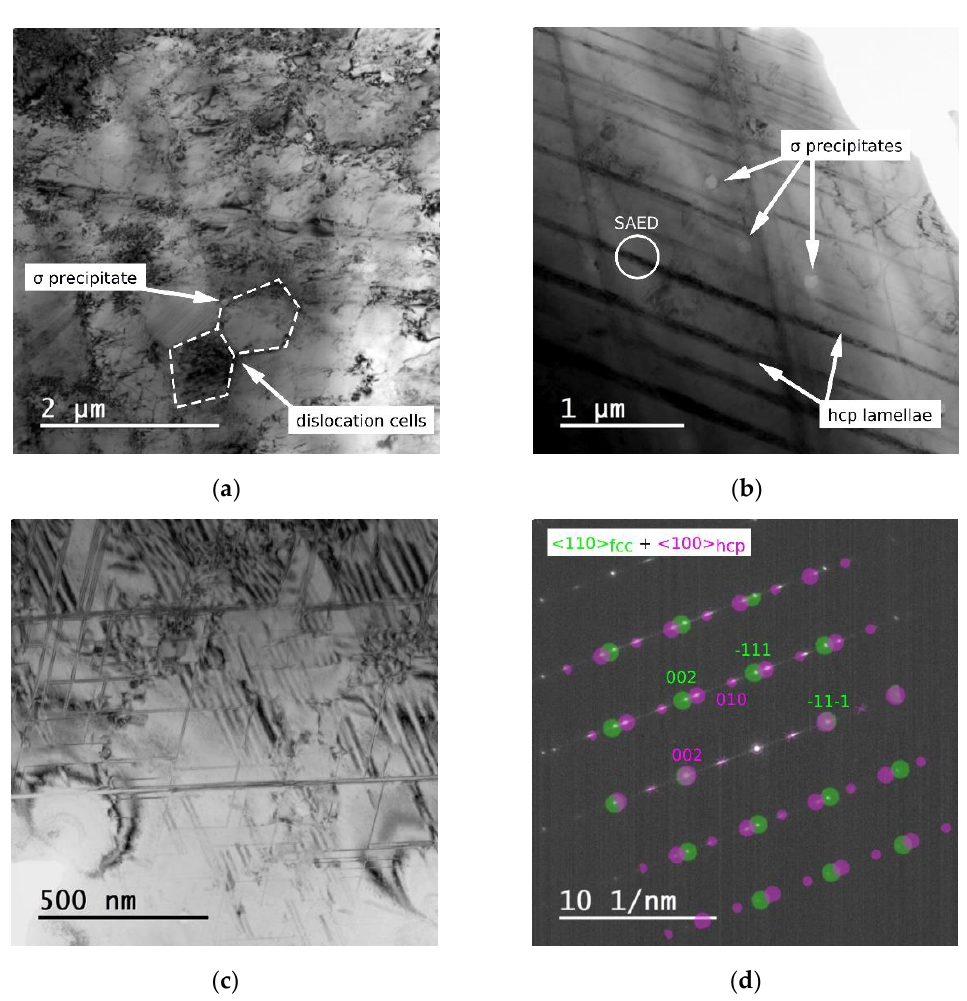
Figure 3. Transmission electron microscopy (TEM) observations of the initial microstructure of the 3D-printed Co-Cr-Mo